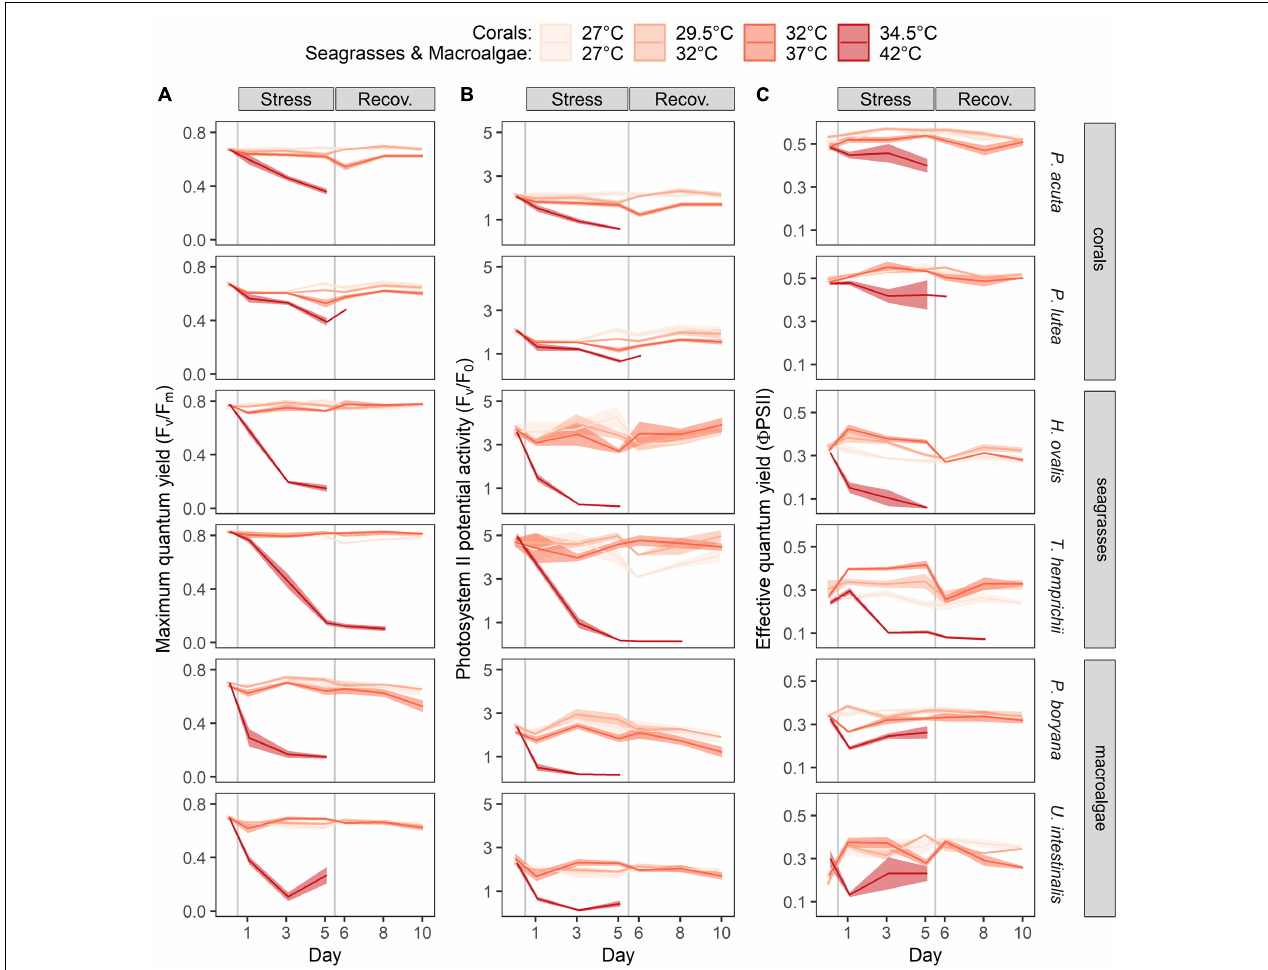
FIGURE 2 | Time course of the warming effects on the photosynthetic parameters of corals, seagrasses and macroalgae. (A) Maximum quantum yield ( F v / F m ), (B) PSII potential activity ( F v / F 0 ) and (C) effective quantum yield ( φ PSII). Values are shown as mean ± SE ( n = 3). For each replicate, 3 individuals were assessed. Corals were subjected to 27–34.5 ◦ C in stress period and 27 ◦ C in recovery period. Seagrasses and macroalgae were subjected to 27–42 ◦ C in stress period and 32 ◦ C in recovery